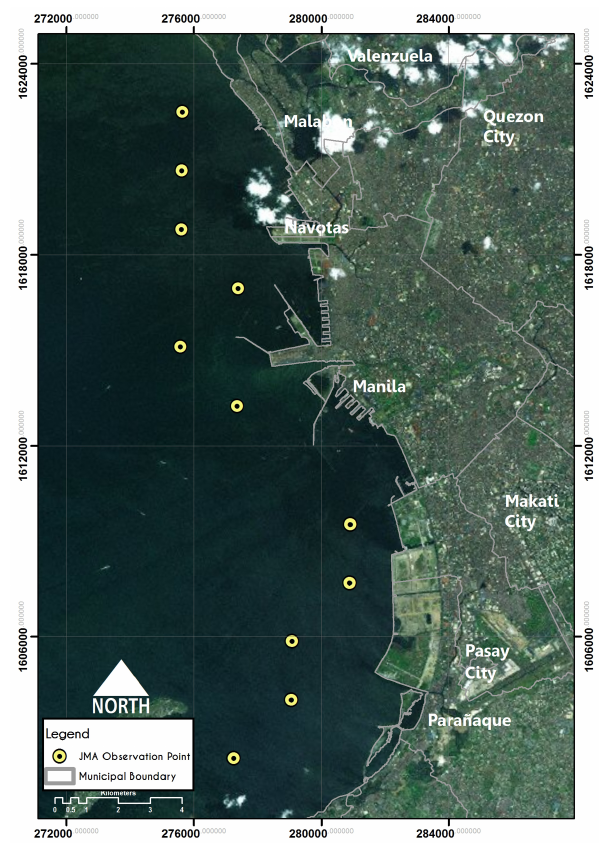
Figure 4. Specified observation points of Metro Manila.